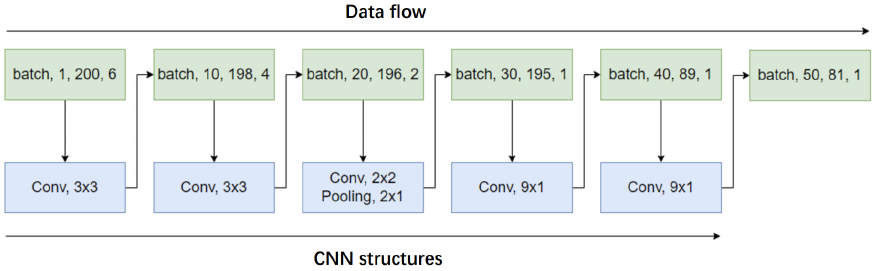
Figure 4. Parameters of Convolution Layer and Data Shape Change in